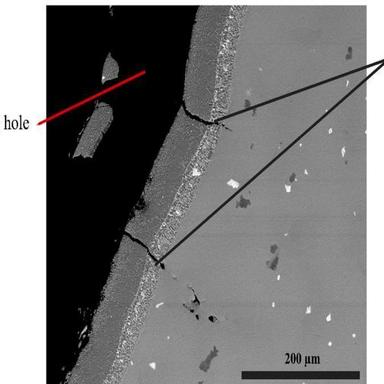
The cooling hole cracking due to the dramatic thermal gradient.